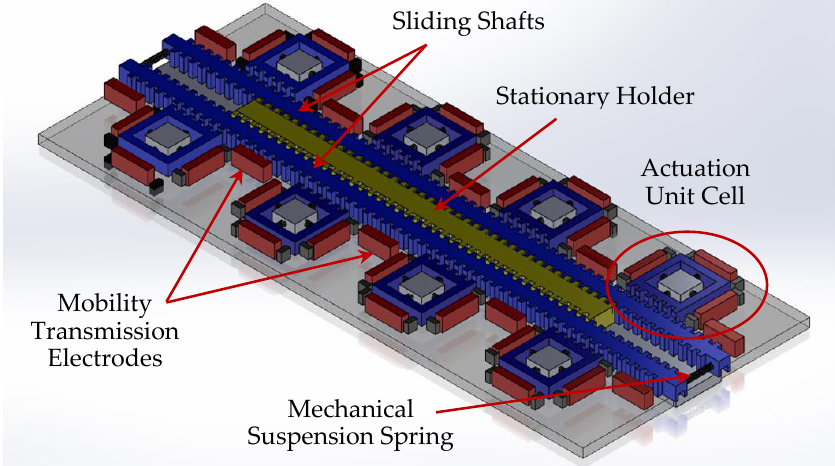
Figure 1. System concept of a multistage, multistable inchworm motor, illustrated by four pairs of actuation unit cells (AUC) distributed at both sides of two connected sliding shafts (long blue structures), which are pulled together by mechanical suspension springs and held at idle states by a central stationary holder (yellow). The mobility transmission electrodes determine whether the shafts are interlocked with the stationary holder or released from it.